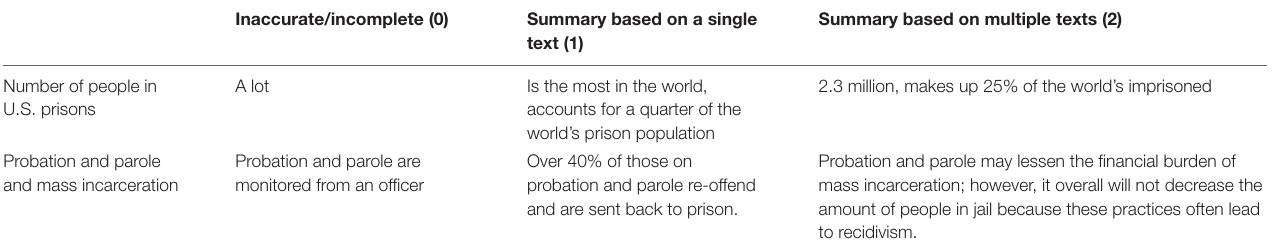
TABLE 4 | Sample open-ended responses.